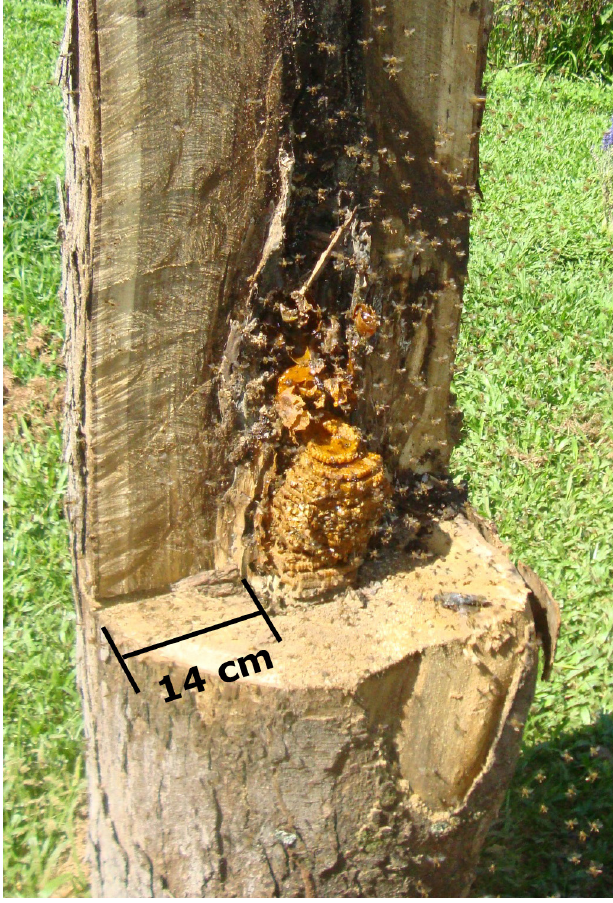
Fig 2 . Trunk thickness of a Tetragona clavipes natural nesting site. (Photo: Raoni